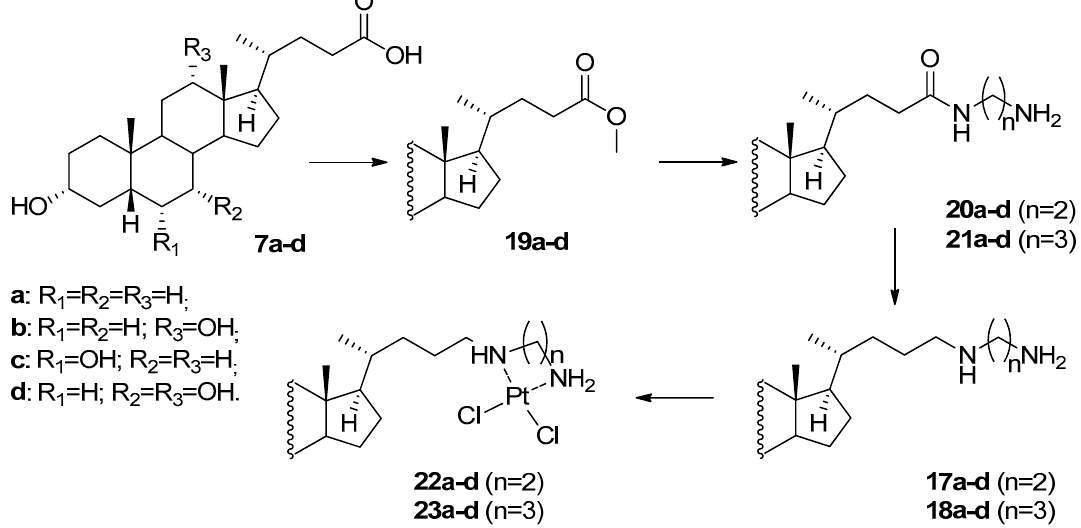
Scheme 2. Synthesis of cisplatin derivatives from different bile acids.